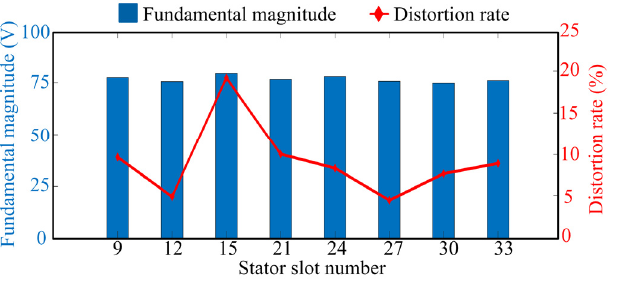
Figure 4. The variation in back EMF with the variation in the number of stator slots when the number of rotor poles is 10.